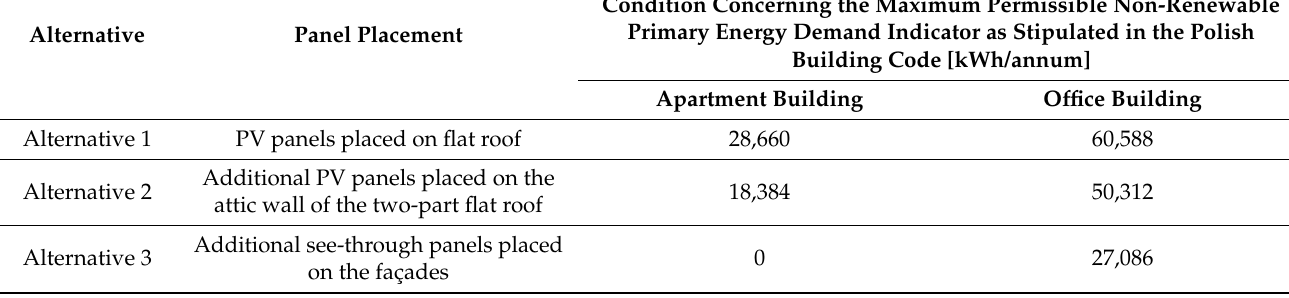
Table 8. Calculation results for energy gap to be bridged in order to meet the nZEB requirements, monthly balance method.